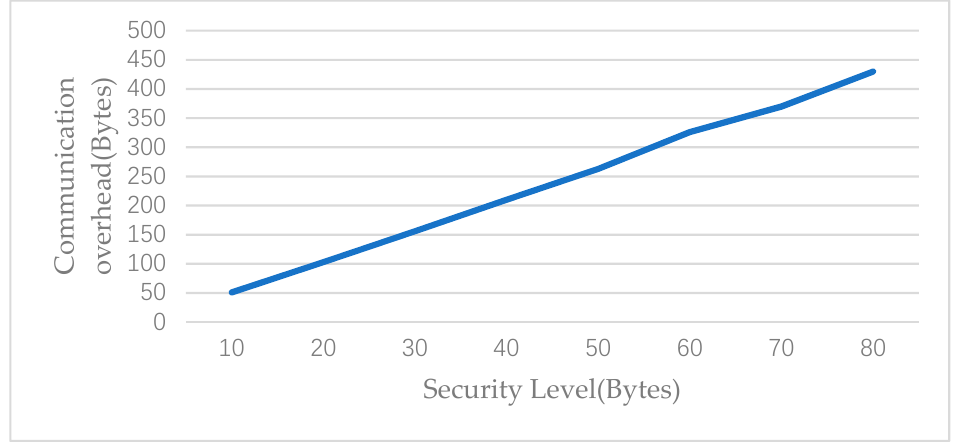
Figure 5. Communication overhead vs. security level.